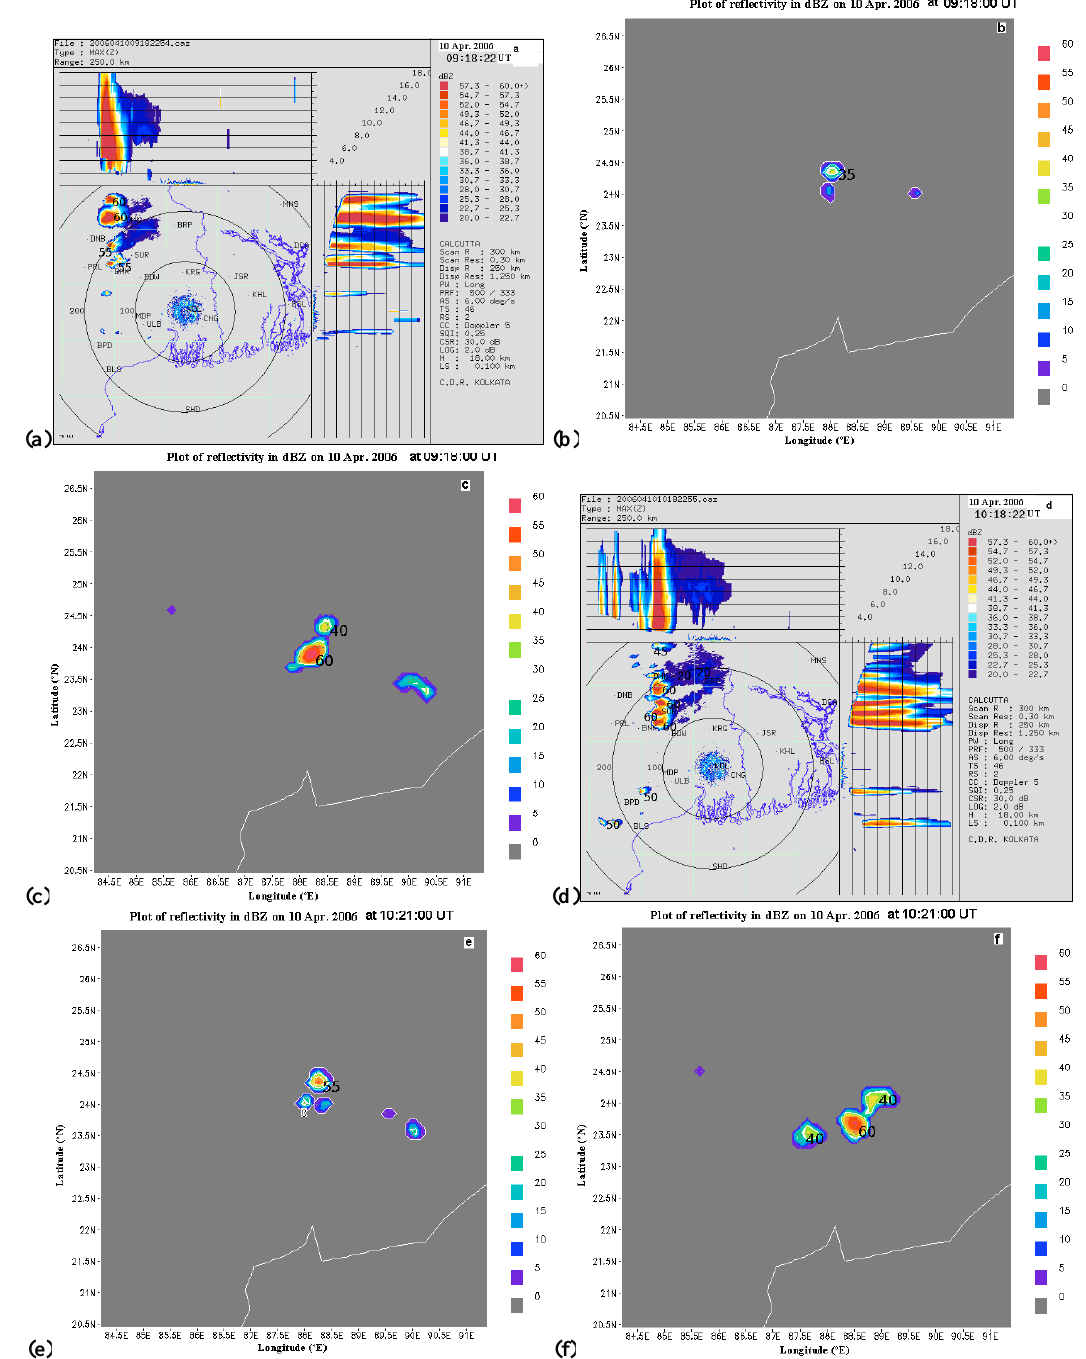
Fig. 6. (a) DWR derived reflectivity Max(Z) at 09:18UT, 10 April 2006. (b) Model simulated reflectivity with default cloud microphysics at 09:18UT, 10 April 2006. (c) Model simulated reflectivity with modified cloud microphysics at 09:18UT, 10 April 2006. (d) DWR derived reflectivity Max(Z) at 10:18UT, 10 April 2006. (e) Model simulated reflectivity with default cloud microphysics at 10:21UT, 10 April 2006. (f) Model simulated reflectivity with modified cloud microphysics at 10:21UT, 10 April